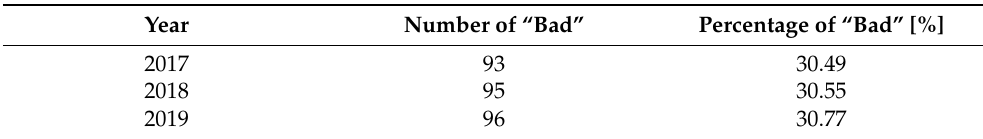
Table 2. Number and percentage of companies included in the analysis and classified as “bad” by year.